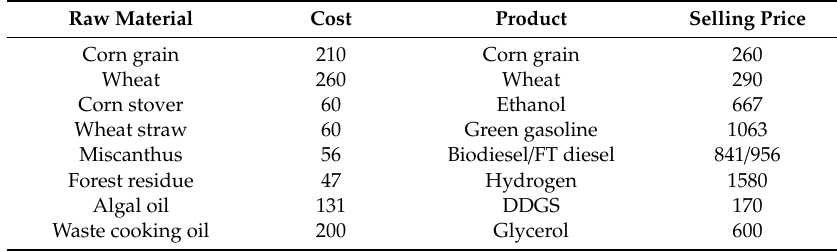
Table 2. Cost of raw materials and selling prices for products in $ /